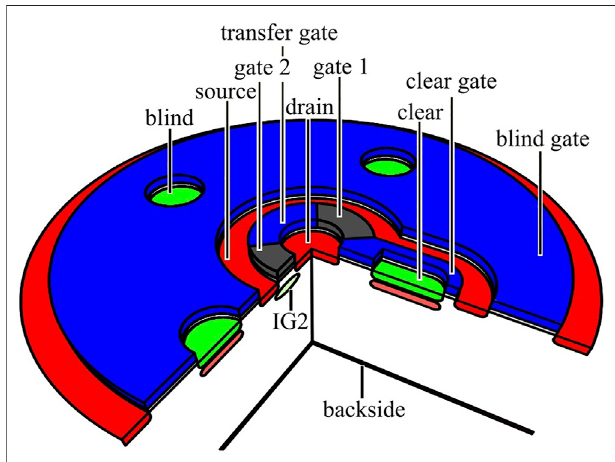
FIGURE 11 | shows a circular RNDR DePFET. It consisting of gate 1, gate two transfer gate as well as clear and clear gate, can be embedded in a blind gate with blind contacts to form a gateable RNDR DePFET